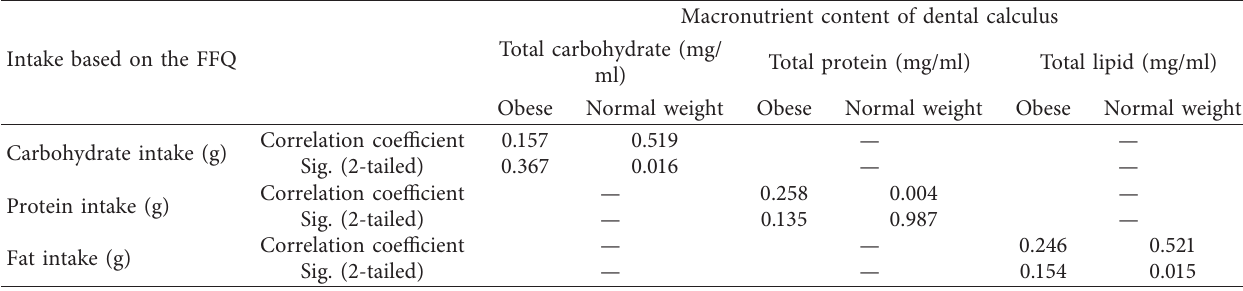
Table 6: Correlation of nutrition intake based on the FFQ and macronutrient content in dental calculus between obese and normal-weight individuals. Intake based on the FFQ